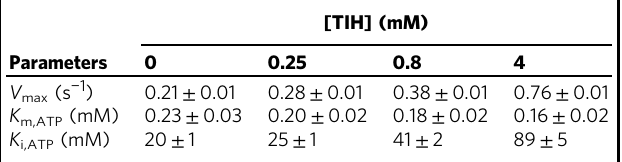
Table 1 Steady-state kinetic parameters for ATP-PRT inhibition in the presence of TIH